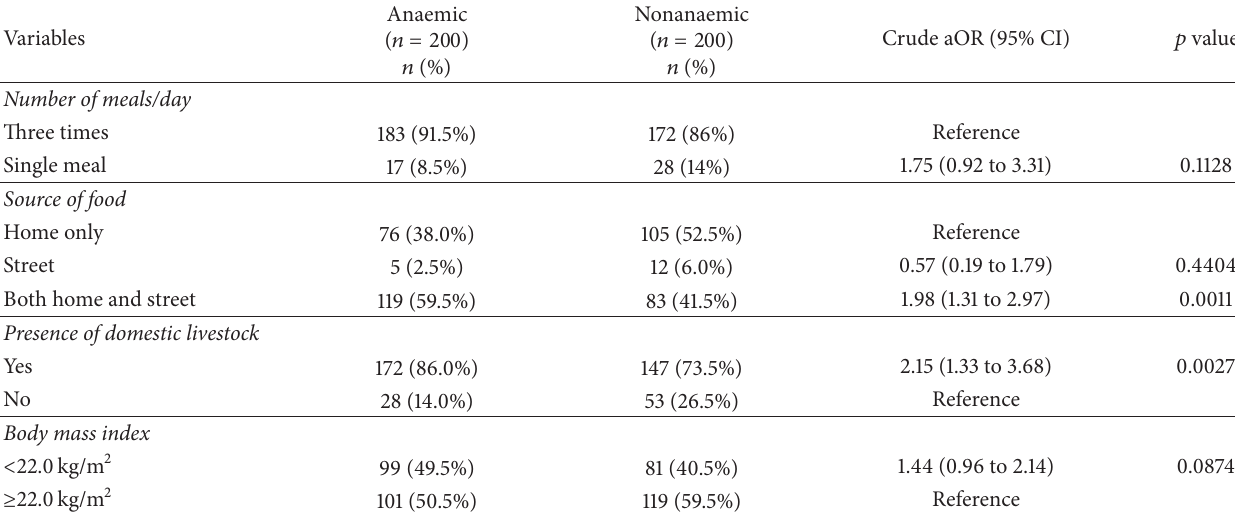
Table 2: Nutrition, BMI, and presence of livestock of study